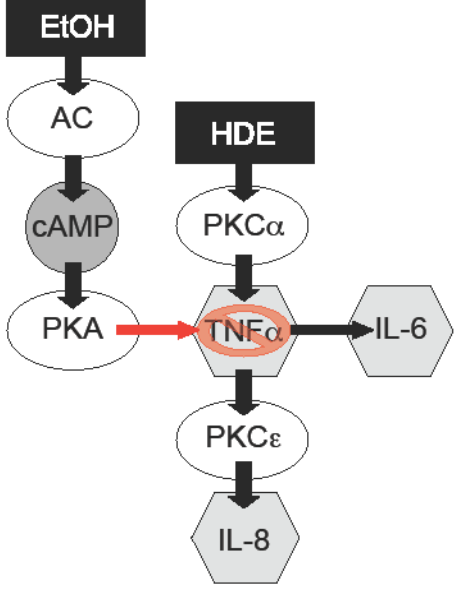
Figure 8. Proposed mechanism by which alcohol exposure ablates HDE-induced